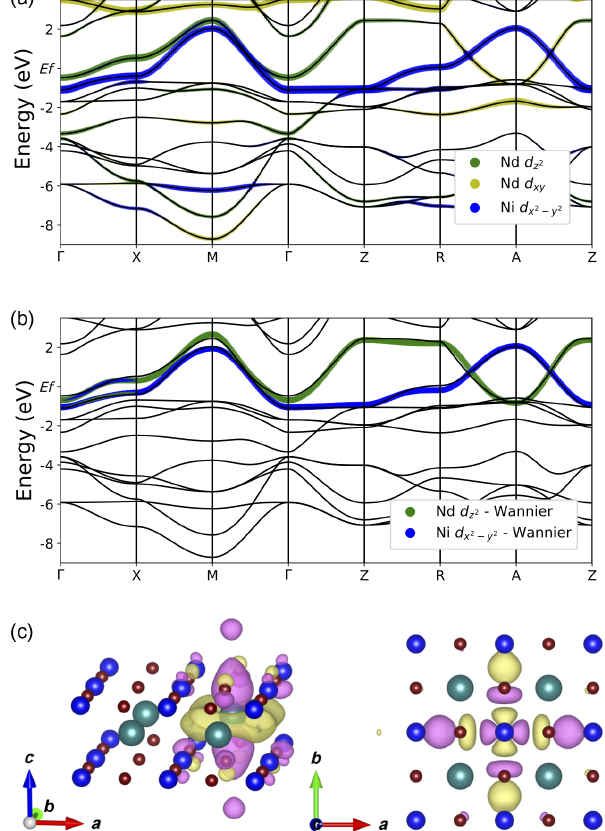
FIG. 4. Wannier downfolding of NdNiO 2 . (a) GGA calculation of NdNiO 2 band structure, and Nd d z 2 (green), Nd d xy (yellow), and Ni d x 2 − y 2 (blue) atomic orbital content. (b) Dispersion of two- orbital model based on the Wannier downfolding on the Wannier orbitals shown in panels (c). (c) Nd d z 2 -like and Ni d x 2 − y 2 -like Wannier